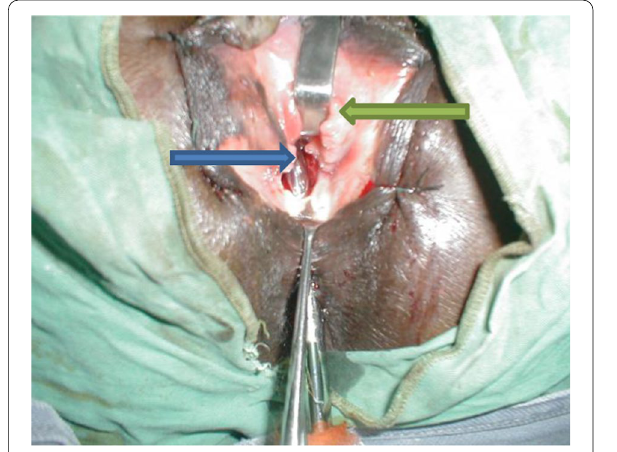
Fig. 2 Obstetric urinary fistula with complete urethral loss. Image shows vesico‑vaginal fistula with complete urethral loss (green arrow) and rectovaginal fistula (blue arrow)